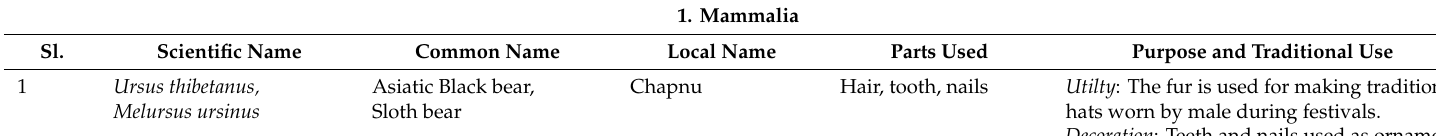
Table 2. Traditional knowledge associated with the Wancho tribe. 1.